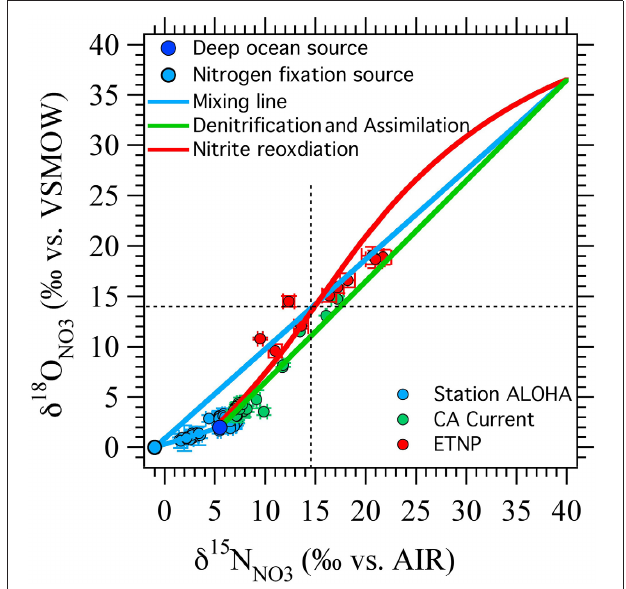
FIGURE 7 | Results from ODZ model compared against published data. Nitrogen fixation (blue circle and blue lines) is efficient at generating and δ 18 O NO negative (cid:2)( 15 , 18 ) values at the lower range of δ 15 N NO 3 3 values, while nitrite reoxidation (red line) has a stronger effect at higher δ 15 N NO and δ 18 O NO values. The nitrite reoxidation curve shown here was 3 3 generated from the box model with k EXCH = 0.5 and F NXR /F NIR = 2 ( Figure 6F , dashed line). Data from station ALOHA (Casciotti et al., 2008) in the north Pacific subtropical gyre is well explained by an input from N 2 fixation. Data from the California Current (Santoro et al., 2010) falls close to the 1:1 line suggesting little influence of nitrogen fixation or nitrite oxidation in the euphotic zone. Most of the data from the ETNP (Casciotti and McIlvin, 2007) could be explained by either nitrite reoxiation or nitrogen fixation, but two points (which fall in the shallow oxycline at the top of the SNM) require inputs from both nitrite reoxidation and nitrogen